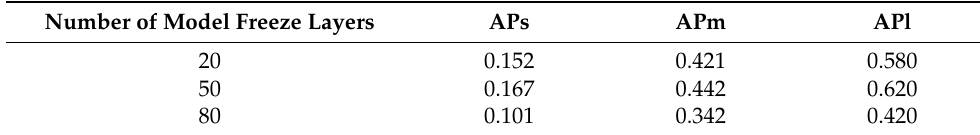
Table 3. Model freezing performance comparison.